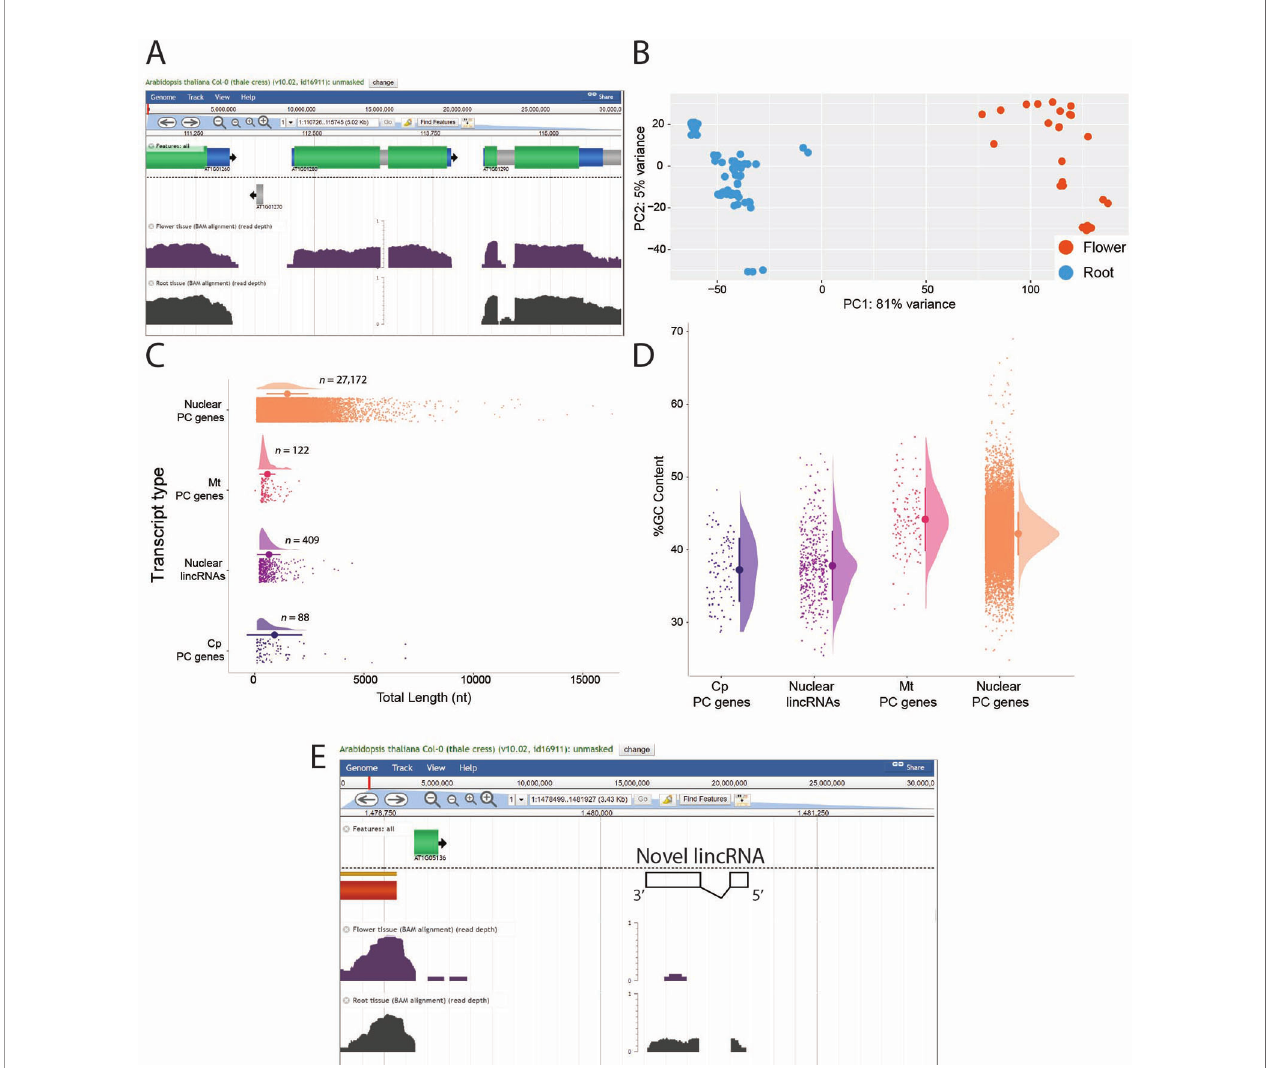
FIGURE 3 | Examples of downstream analyses facilitated by the read mapping and transcript assembly (RMTA) work fl ow. The output generated by RMTA are immediately useful for the usual analyses performed following an RNA-sequencing experiment. (A) EPIC-CoGe screenshot of Arabidopsis root and fl ower RNA- sequencing (RNA-seq) data processed by RMTA highlighting a gene, AT1G01280 , that is highly expressed in fl ower tissue but not roots. (B) Principal component analysis (PCA) of 100 Arabidopsis sequence read archives (SRAs) generated in R using the read count output fi le from RMTA. (C) Comparison of the length of Evolinc identi fi ed long non-coding RNA (lncRNAs) relative to other nuclear and organellar genes. PC, protein-coding gene; Mt, mitochondria; Cp, chloroplast. (D) Comparison of GC content of Evolinc identi fi ed lncRNAs relative to other nuclear and organellar genes. (E) EPIC-CoGe visualization of the expression of a locus identi fi ed by Evolinc as a lncRNA. The boundaries of the lncRNA and its orientation have been added to the EPIC-CoGe